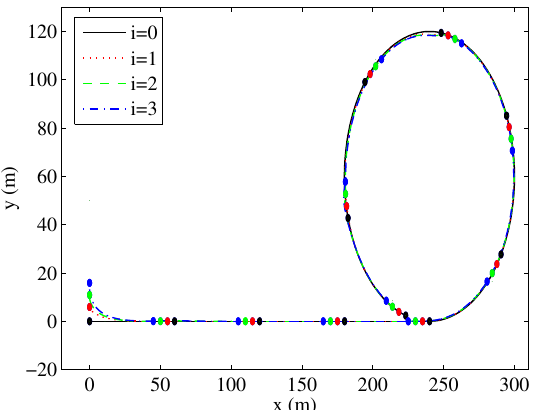
Figure 9. The north-east position of the four USVs under NN adaptive